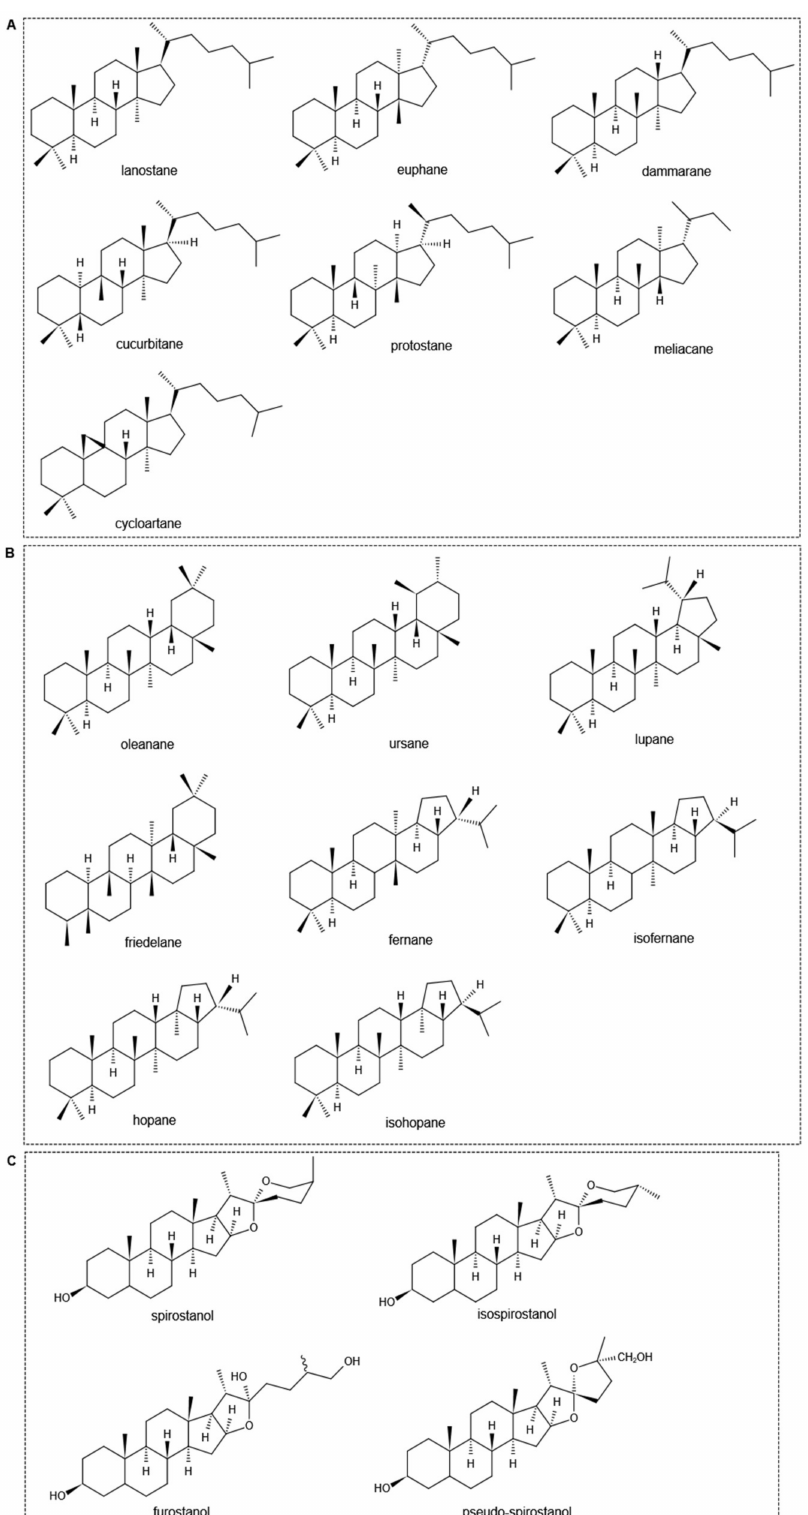
Figure 1. Chemical structures of different subgroups of tetracyclic triterpenoid saponins ( A ), penta- cyclic triterpenoid saponins ( B ), and steroidal saponins ( C